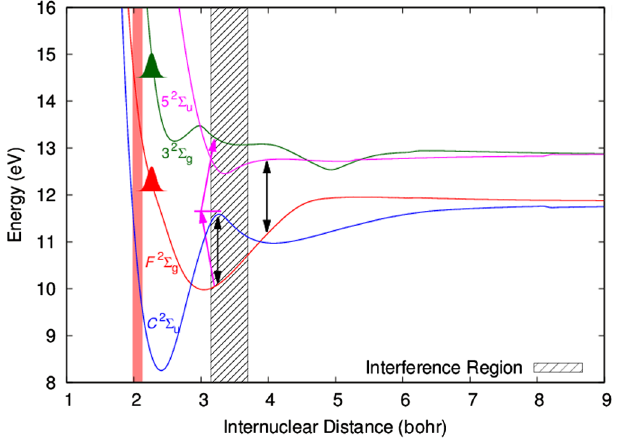
FIG. 7. PECs with schematic depiction of initial populations shortly after ionization. Red transparent area: Franck-Condon region. Black striped area: region with significant population transfer between the 3 2 Σ and F 2 Σ state for time delays where g g the interference is observed. The magenta single-headed arrows depict the two-photon process populating the 3 2 Σ state using the g 5 2 Σ state as a virtual intermediate state. The black double- u headed arrows show points of resonant single-photon